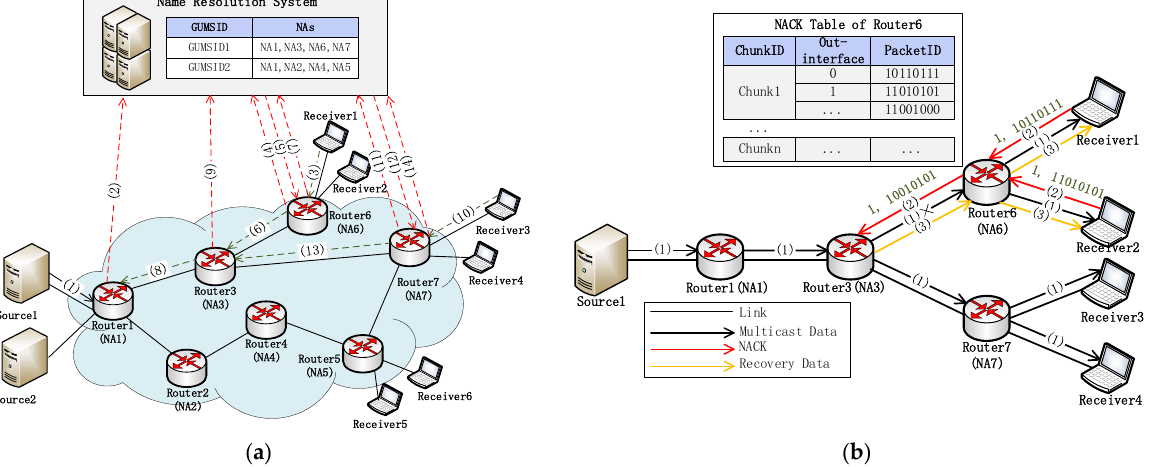
Figure 1. Overview of reliable multicast architecture in ICN. ( a ) The establishment process of multicast tree; ( b ) multicast data transmission and loss recovery process.